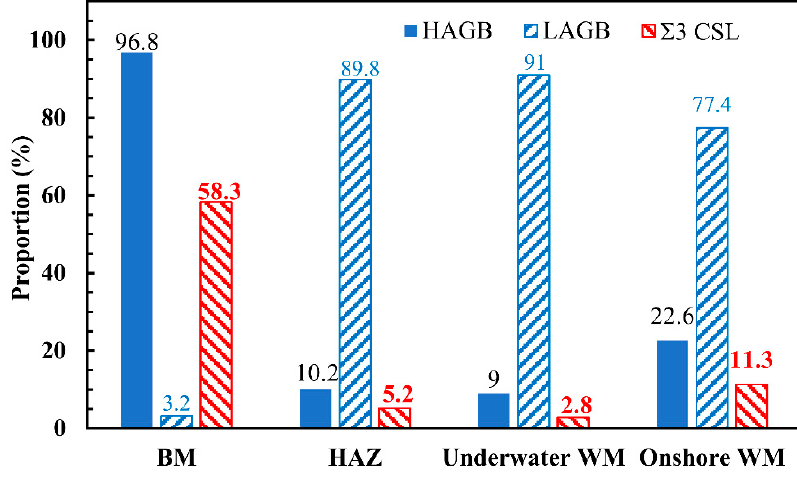
Figure 10. The proportion of high-angle grain boundaries (HAGB), low-angle grain boundaries (LAGB) and Σ 3 coincidence site lattice (CSL) boundaries for austenite in the BM, HAZ, underwater WM and onshore